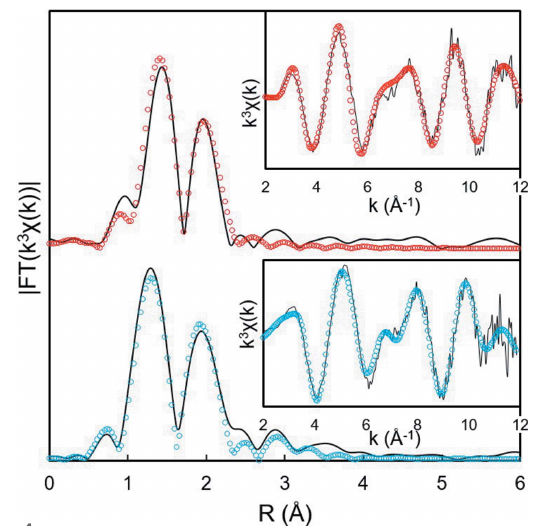
Figure 4 Experimental FT EXAFS signal (line) and best fits (open circles) obtained after 30 min electrolysis at 1150 mV/(Ag/AgCl) (blue) and at 750 mV/(Ag/AgCl) (red). The inset is the corresponding k 3 -weighted EXAFS oscillations.